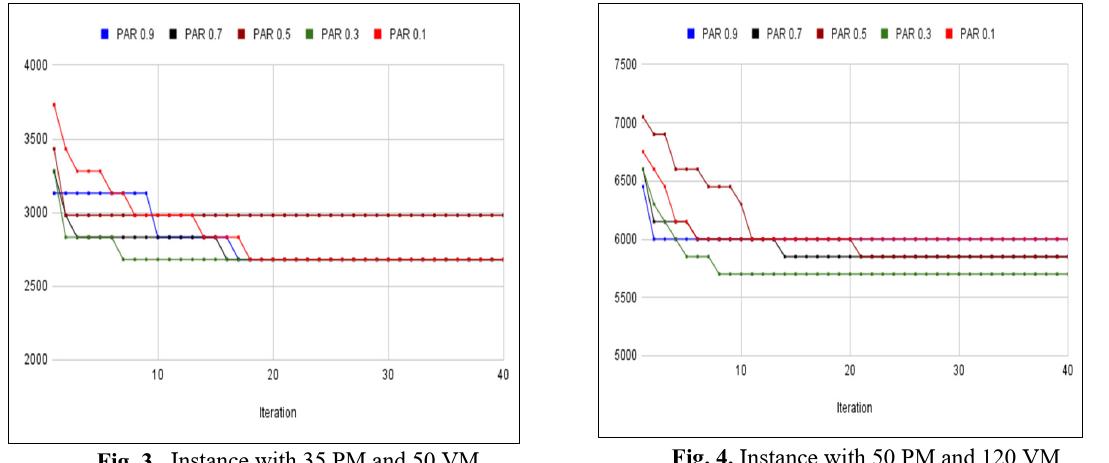
Fig. 3. Instance with 35 PM and 50 VM Fig. 4. Instance with 50 PM and 120 VM